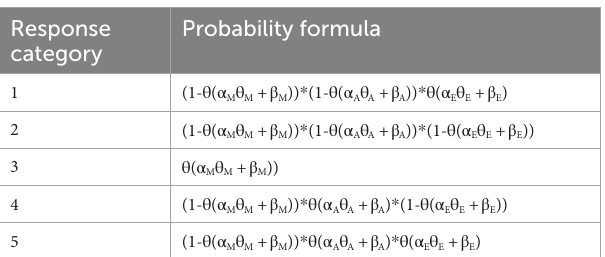
TABLE 1 Category probabilities based on the